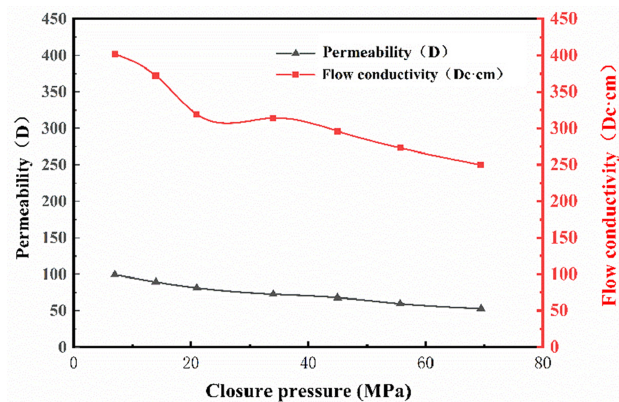
Figure 5. Permeability and diversion capacity of pure proppant at different closure pressures. Table 2. Parameters of the different experimental